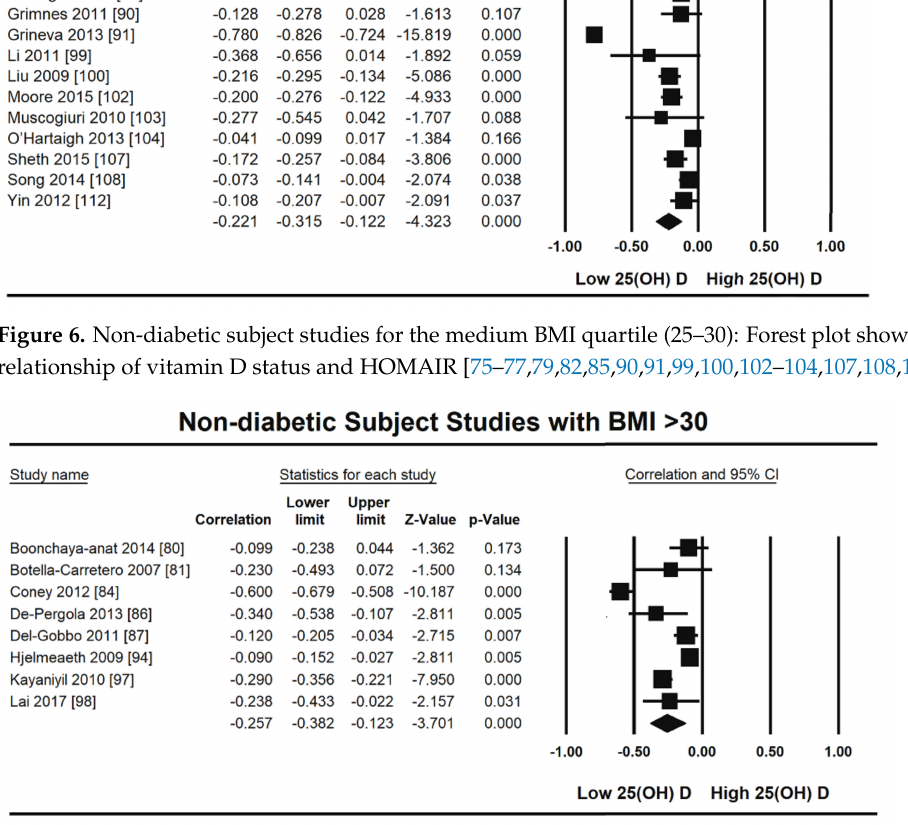
Figure 7. Non-diabetic subject studies for the highest BMI quartile (>30). Forest plot showing the relationship of vitamin D status and HOMAIR